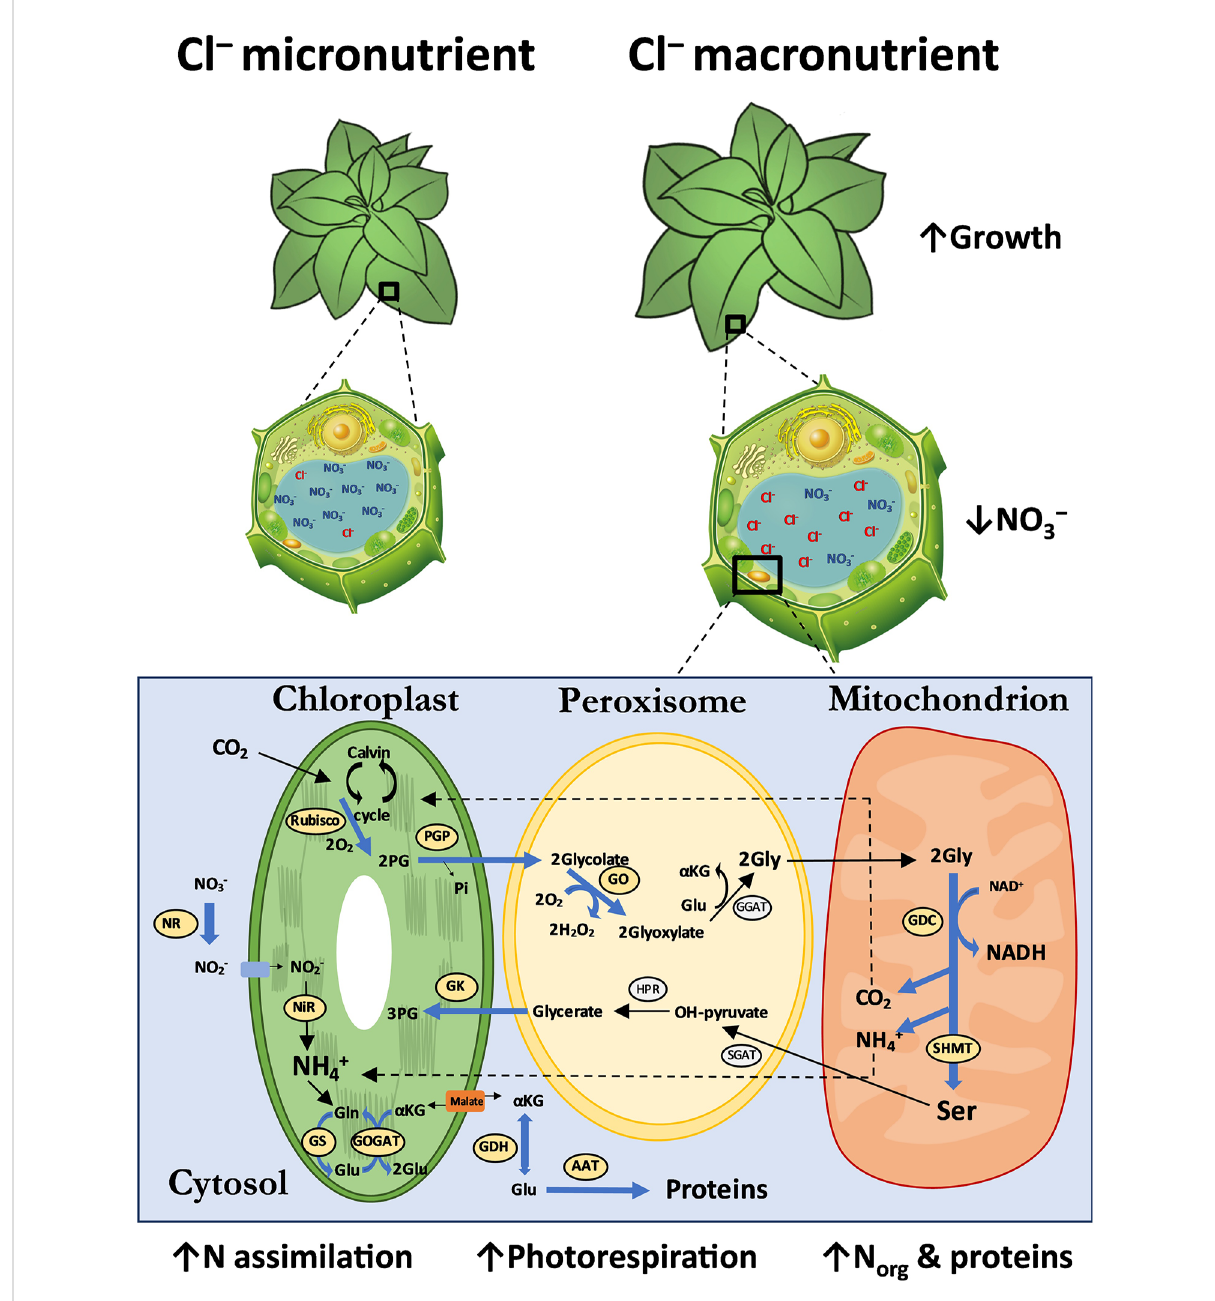
FIGURE 7 Integrative model of anatomical, cellular and metabolic responses to Cl − nutrition at macronutrient levels. The 0 and 6 mM Cl − treatments containing similar cationic balance are represented as Cl − micronutrient (0.075 mM Cl − ) and Cl − macronutrient (6.075 mM Cl − ). The leaf anatomical and cellular parameters (Franco-Navarro et al., 2019), and N metabolism analyzed are schematically represented. The blue arrows represent the up-regulatory enzymatic responses observed. The font size of the analyzed molecules represents their abundance under Cl − treatment. AAT, aspartate aminotransferase; GDC, glycine decarboxylase; GDH, glutamate dehydrogenase; GGAT, glutamate:glyoxylate aminotransferase; GK, glycine kinase; Gln, glutamine; Glu, glutamic acid; Gly, glycine; GO, glycolate oxydase; GOGAT, glutamate synthase; GS, glutamine synthetase; HPR, hydroxypyruvate reductase; NAD, nicotinamide adenine dinucleotide; NiR, nitrite reductase; NR, nitrate reductase; PG, 3-phosphoglycerate; PGP, phosphoglycolate phosphatase; RuBisCO, ribulose-1,5-biphosphate carboxylase/oxygenase; Ser, serine; SGAT, serine:glyoxilate aminotransferase; SHMT, serine hydroxymethyl transferase; a KG, a -Ketoglutaric